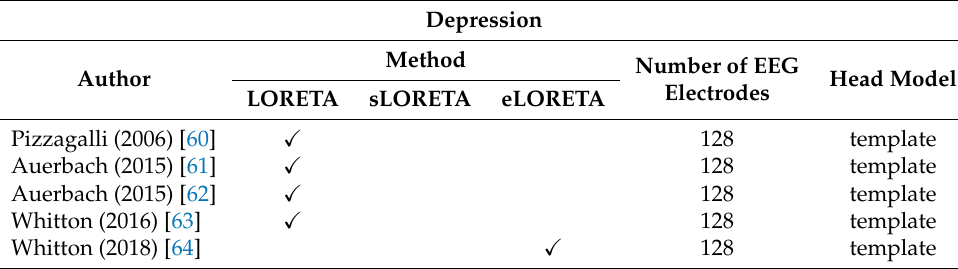
Table 4. Overview of the included papers about